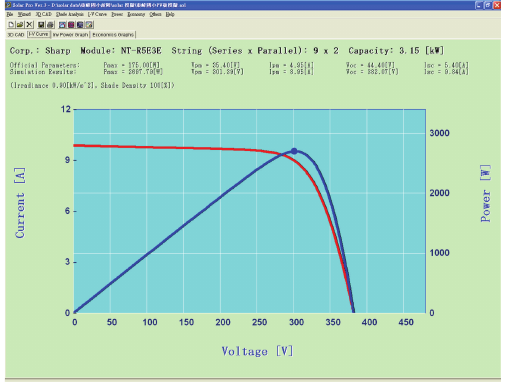
Figure 4: Simulated P-V and I-V curves under 900 W/m 2 irradia- tion and a PV module surface temperature of 51.6 ∘ C.